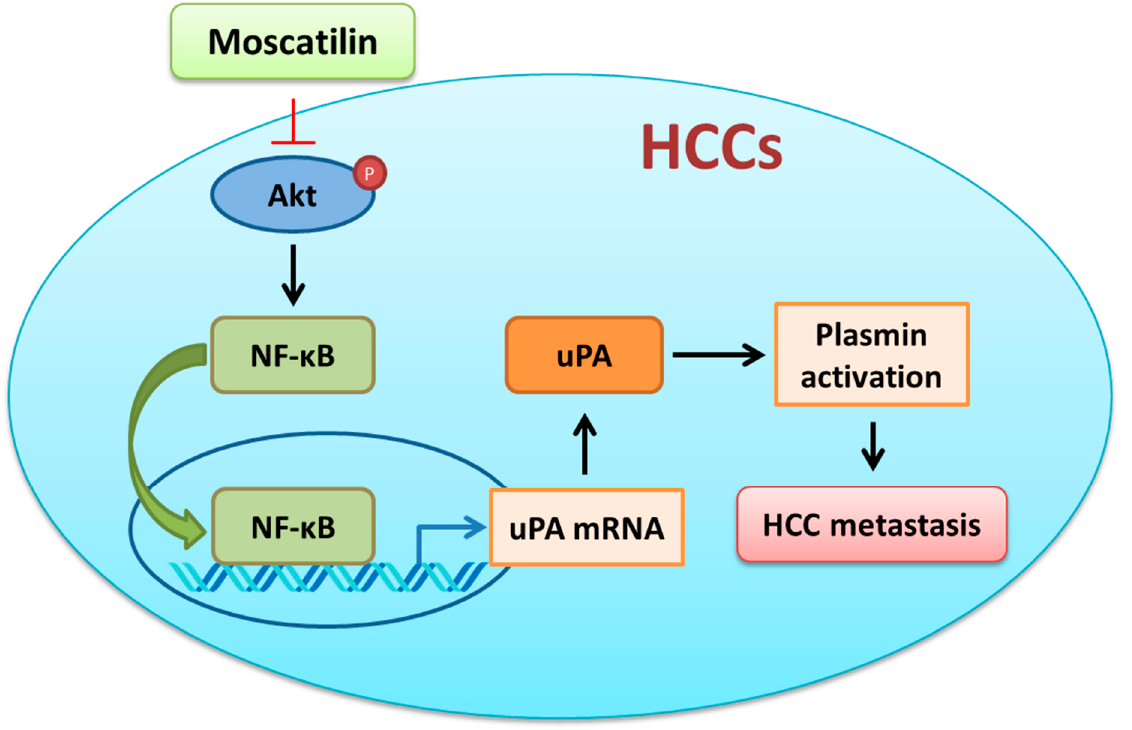
Figure 8. Illustrated model for our proposed molecular mechanism of how moscatilin inhibits HCC cell metastasis through inhibiting uPA expression via down-regulating Akt/NF- κ B signaling pathway.